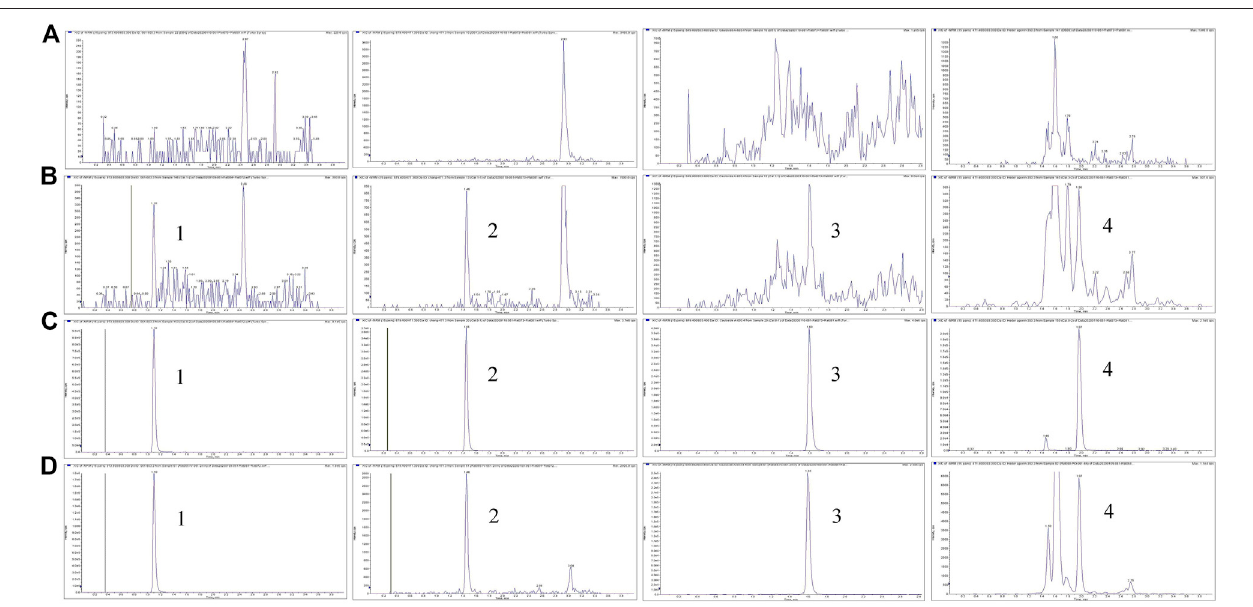
FIGURE 2 | Representative MRM chromatograms for M0, M3, M4, and M5 (A) Blank plasma samples (B) LLOQ samples (C) ULOQ samples (D) Plasma samples after intravenous administration of ASD (10 mg/kg); Peak 1, M0 (t R (cid:2) 1.0 min); Peak 2, M3 (t R (cid:2) 1.46 min); Peak 3, M4 (t R (cid:2) 1.60 min); Peak 4, M5 (tR (cid:2) 1.97 min).